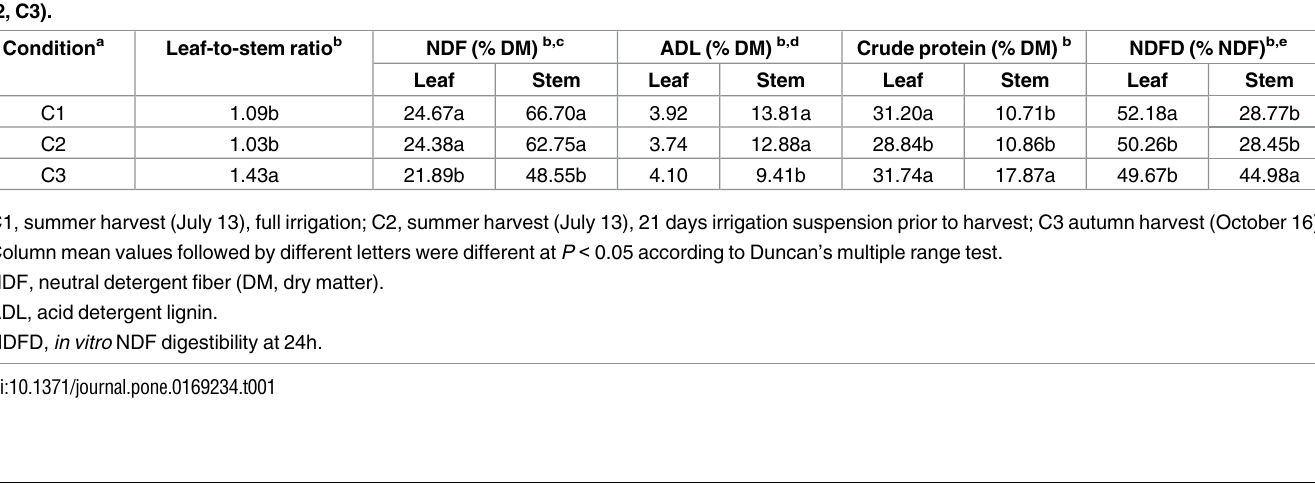
Table 1. Mean values of forage quality traits recorded on dry leaves and stems of 154 alfalfa half-sib progenies in three growing conditions (C1, C2, C3). Condition a Leaf-to-stem ratio b